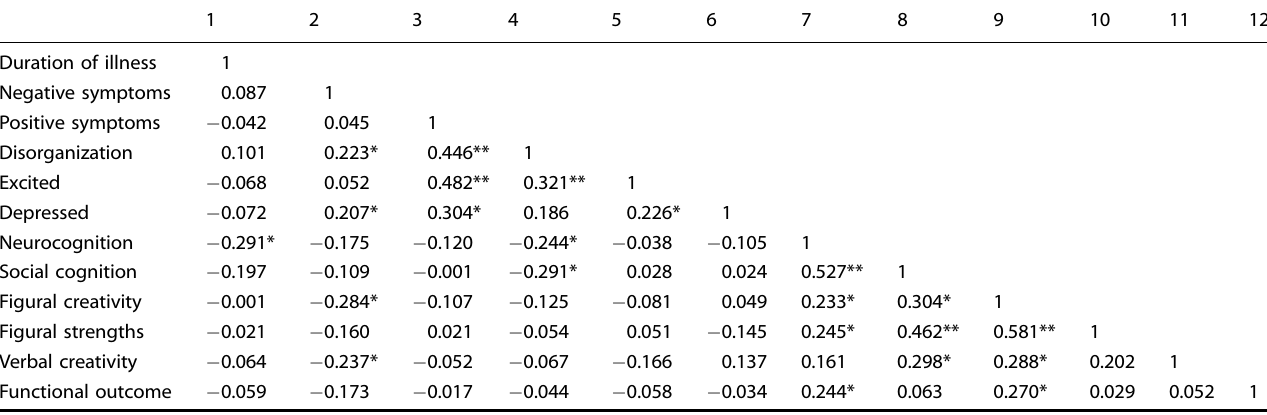
Table 3. Correlations between clinical characteristics, neurocognition, social cognition, creativity, and functional